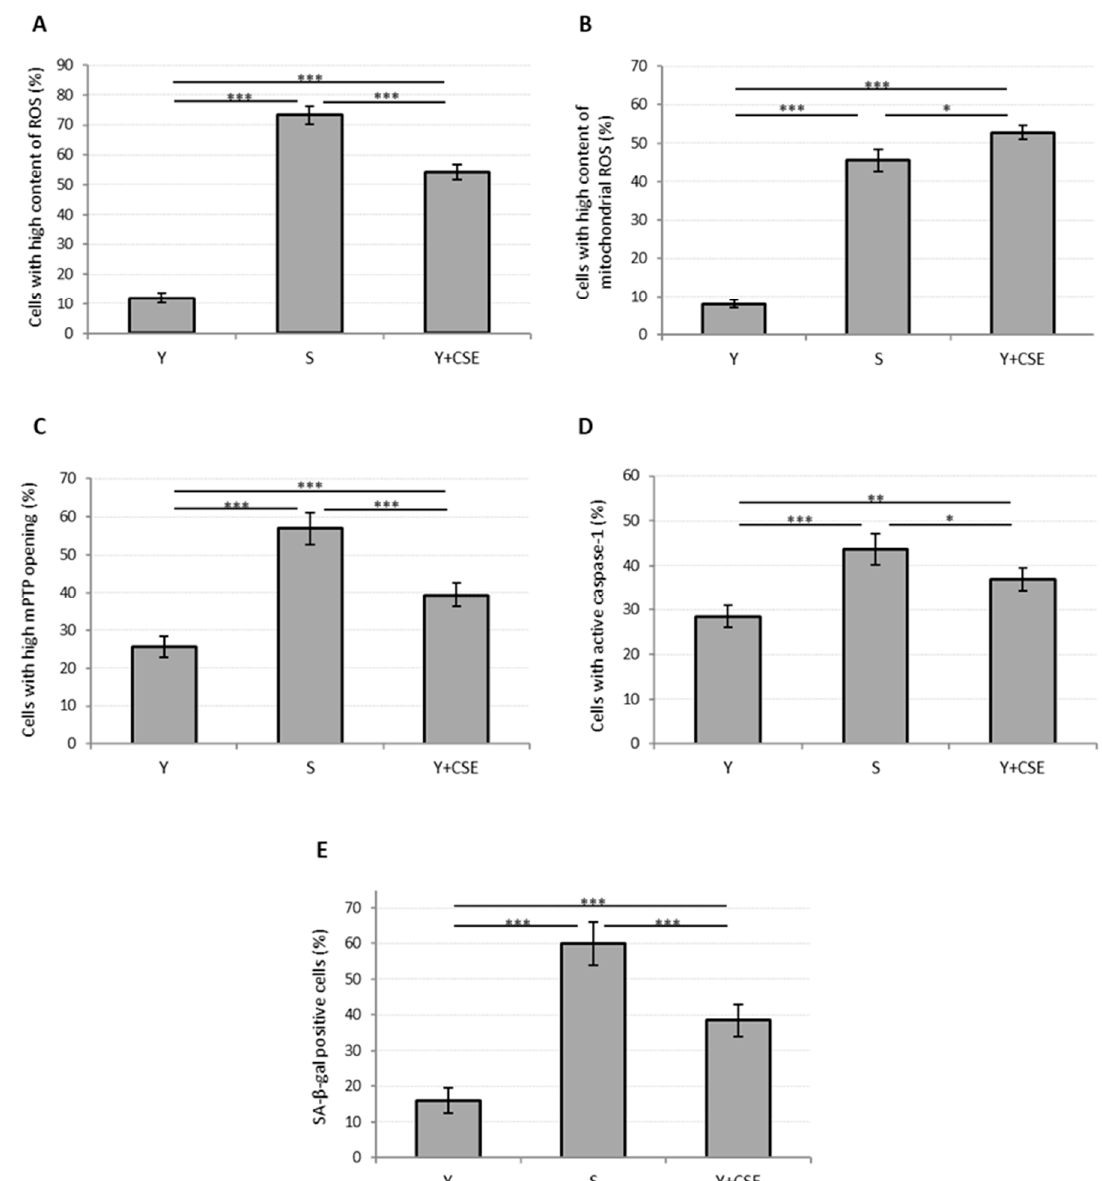
Figure 3. Oxidative stress, mitochondrial functionality, caspase-1 activation and senescence in young HUVECs exposed to CSE (0.425 puffs/mL for 24 h). The histograms depict the results obtained from untreated young ( Y ) and untreated senescent ( S ) HUVECs and young HUVECs exposed to CSE (Y + CSE), that show the percentage of cells with: ( A ) high ROS content, ( B ) high mitochondrial ROS content, ( C ) high mPTP opening, ( D ) active caspase-1, ( E ) SA- β -galactosidase positive cells. * p ≤ 0.05, ** p ≤ 0.01, *** p ≤ 0.001.